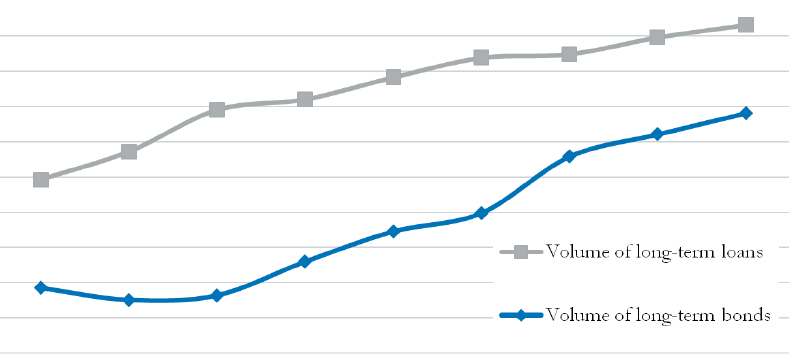
Fig. 2 - The development of total volume of long-term corporate loans and bonds in the Czech Republic in the years 2006–2014 (mil. CZK). Source: own, based on the data from CNB It is clear from the chart (Fig. 2) that both loan and bond financing grew throughout almost the entire observed time period. At the same time, it can be stated that the share of bonds in long- term debt financing increased, as bond financing grew faster. The gap between both curves reached its peak in 2008 (263,22�.6� mil. CZK). Since then, it rather has got a tendency to close. By the end of the year 2014, the gap between loans and bonds amounted only to